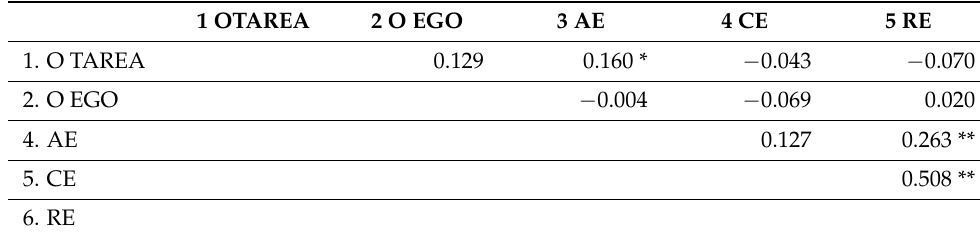
Table 1. Data obtained from the correlations carried out as preliminary